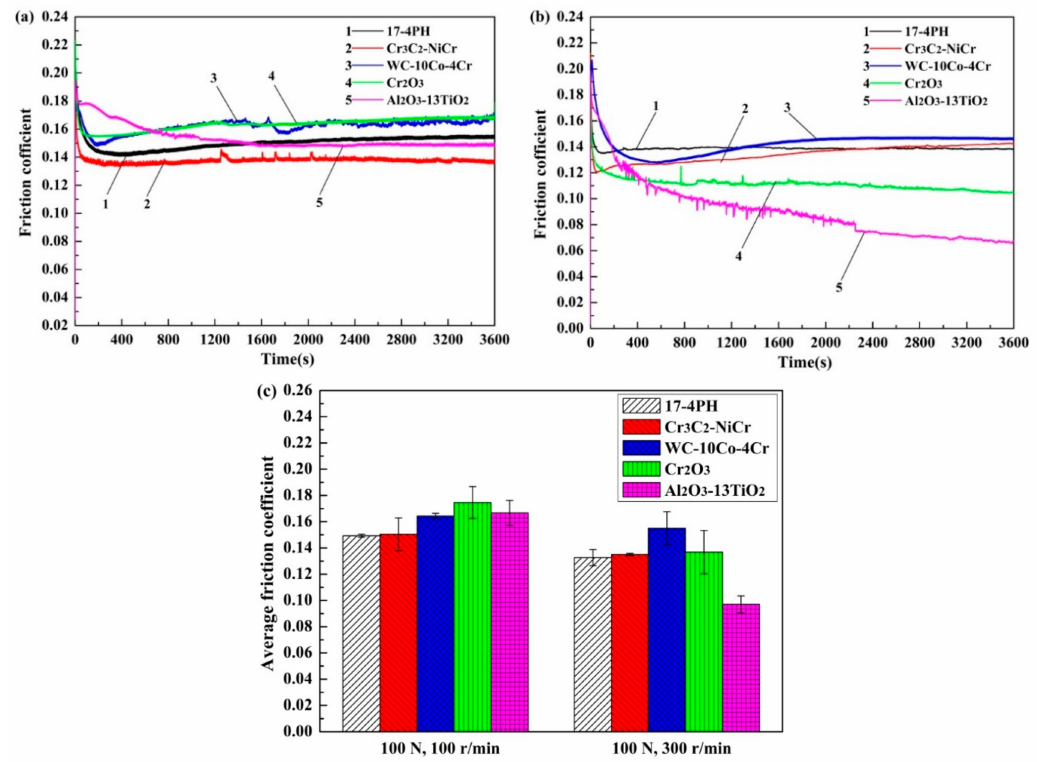
Figure 3. Friction coe ffi cients of 17-4PH and several coatings sliding against CF-PEEK: ( a ) 100 N, 100 r / min; ( b ) 100 N, 300 r / min and ( c ) the mean friction coe ffi